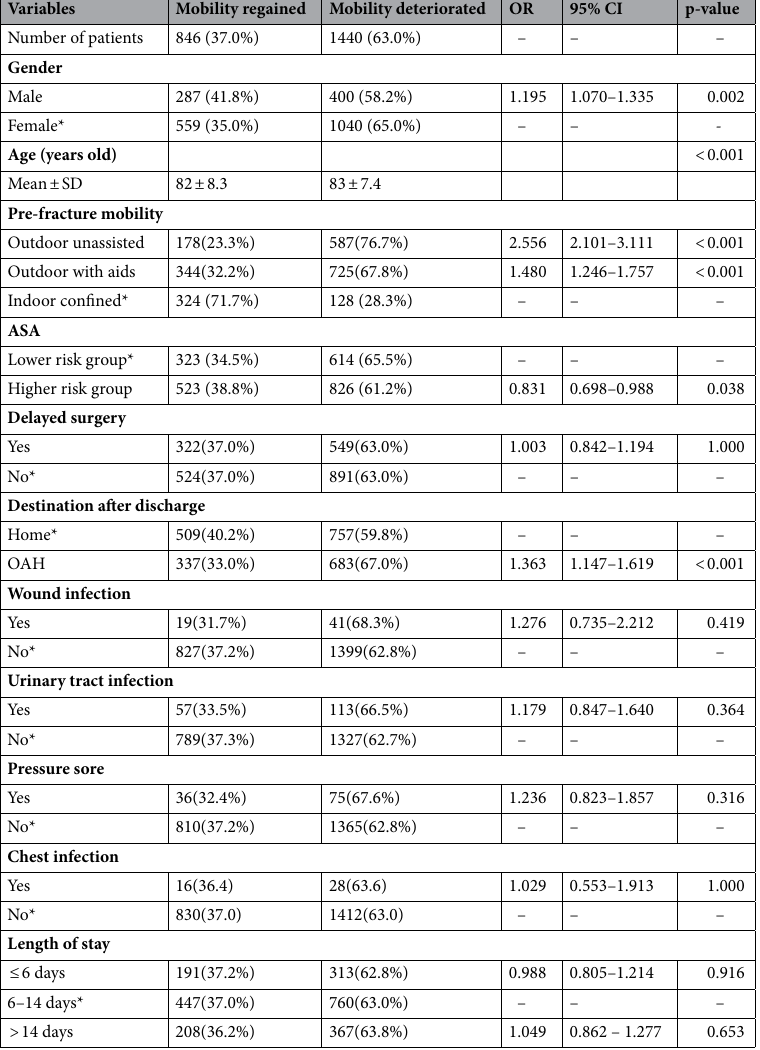
Table 2. Clinical characteristics and statistical analysis results of different groups of patients stratified by mobility category. *Reference